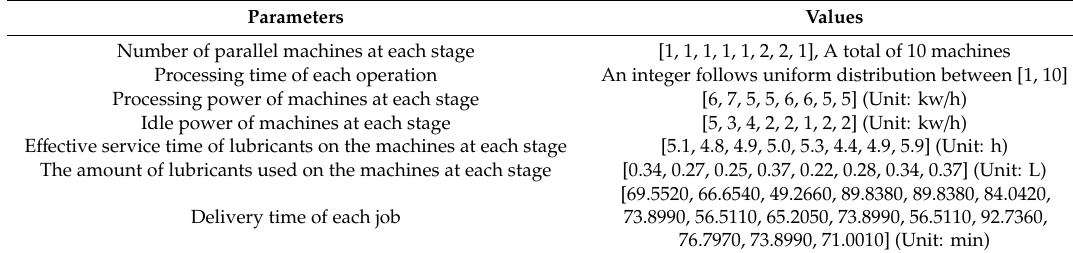
Table 10. Relevant parameters in factory 1.